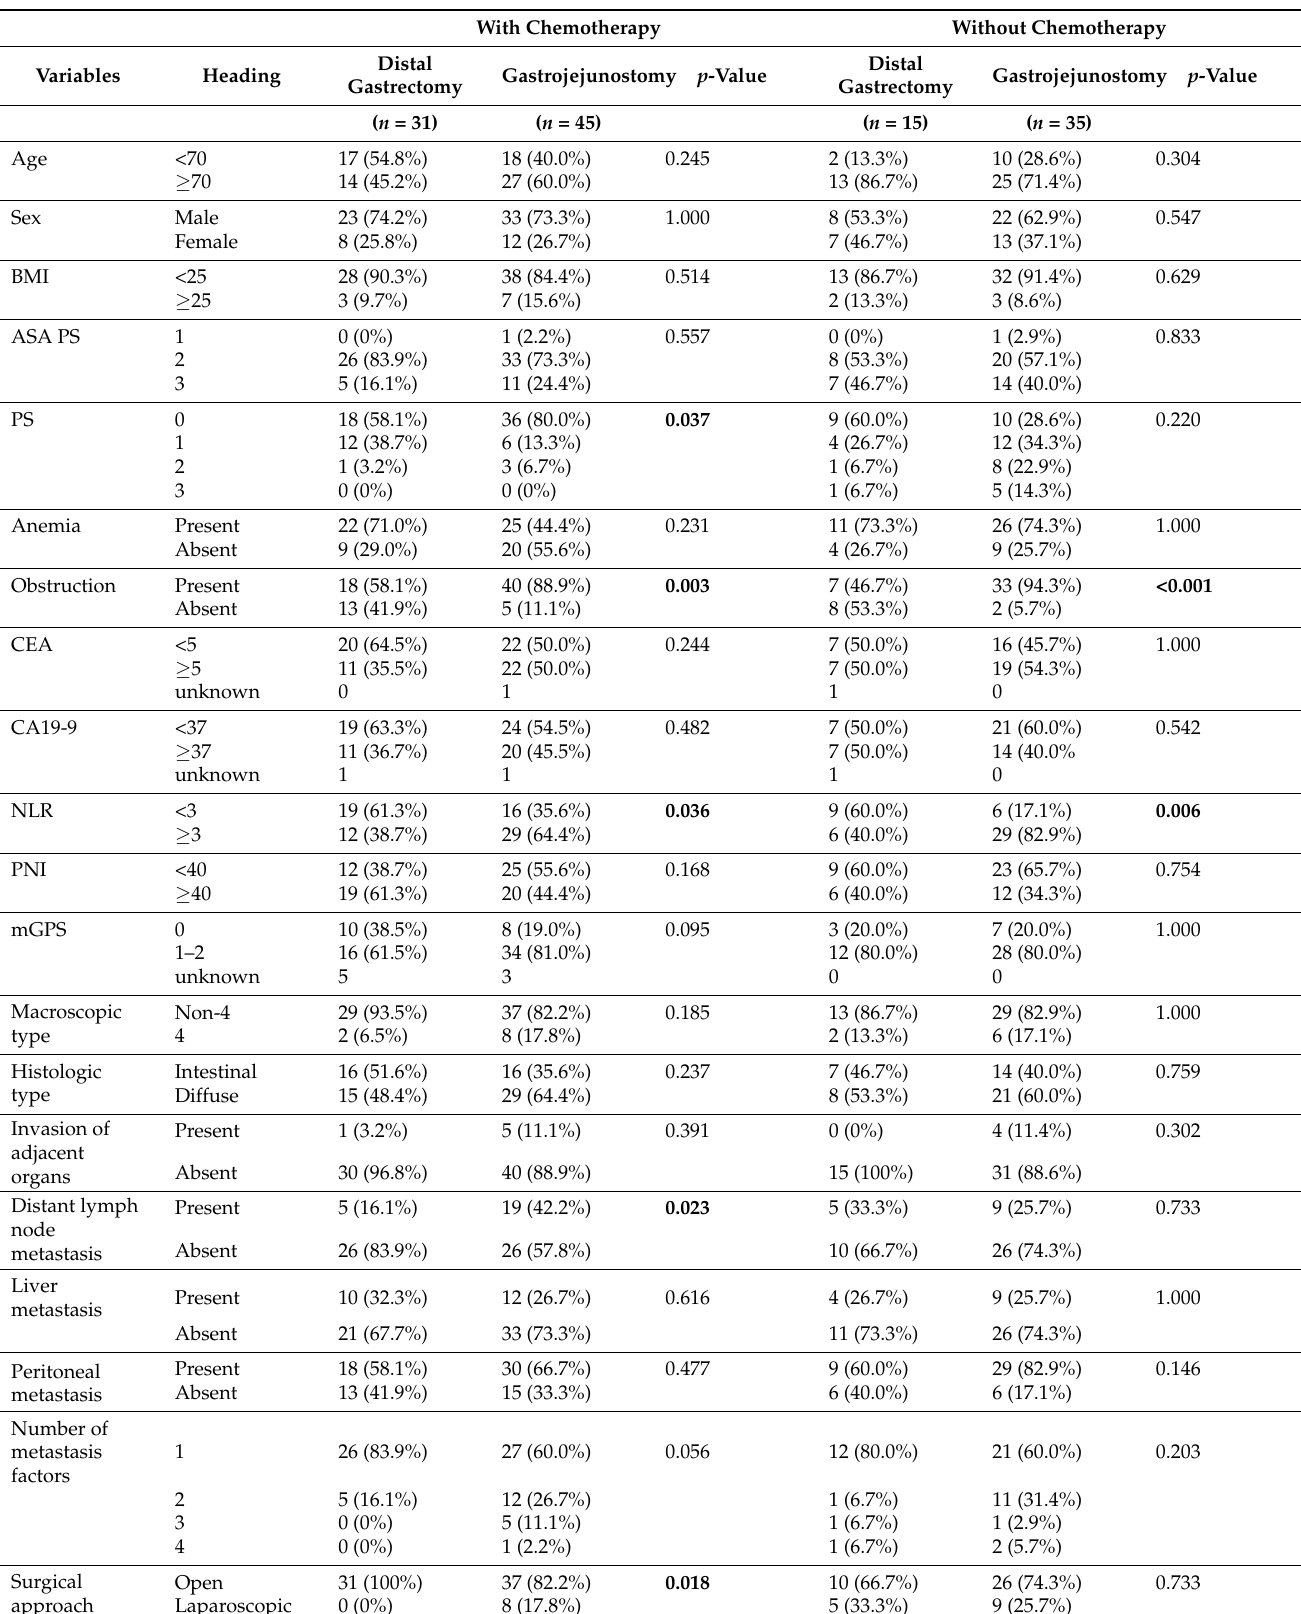
Table 3. General characteristics before propensity score